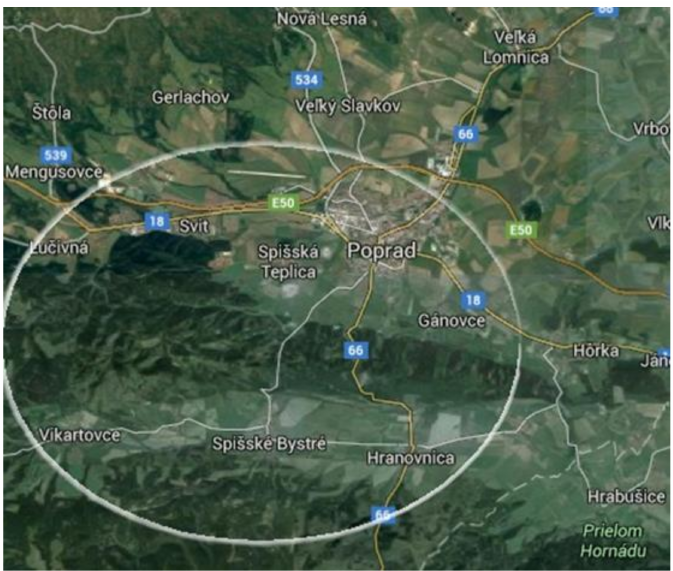
Figure 2. Data collection sites (Poprad, Spišsk á Teplica, Hranovnica, Spišsk é Bystr é , Vikartovce). Source: